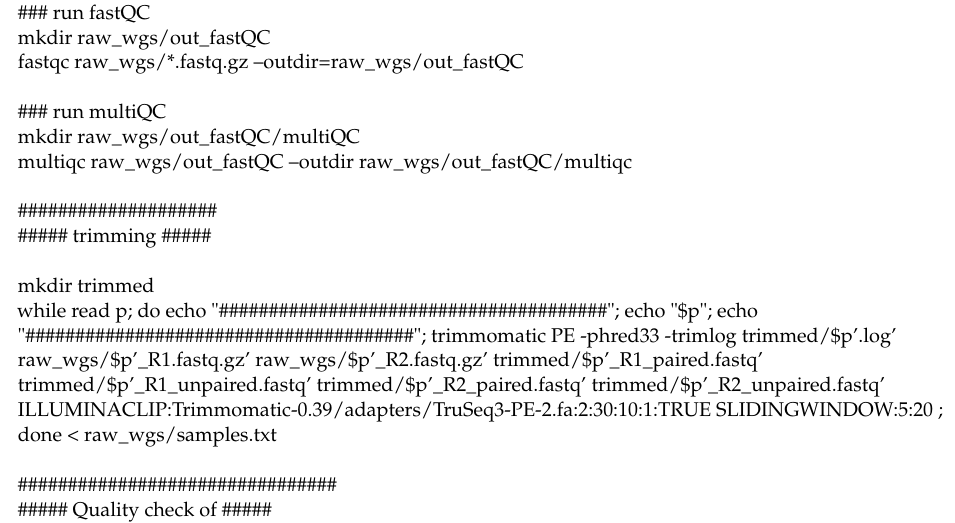
Algorithm A1 . Unix commands used for the assembly of the WGS